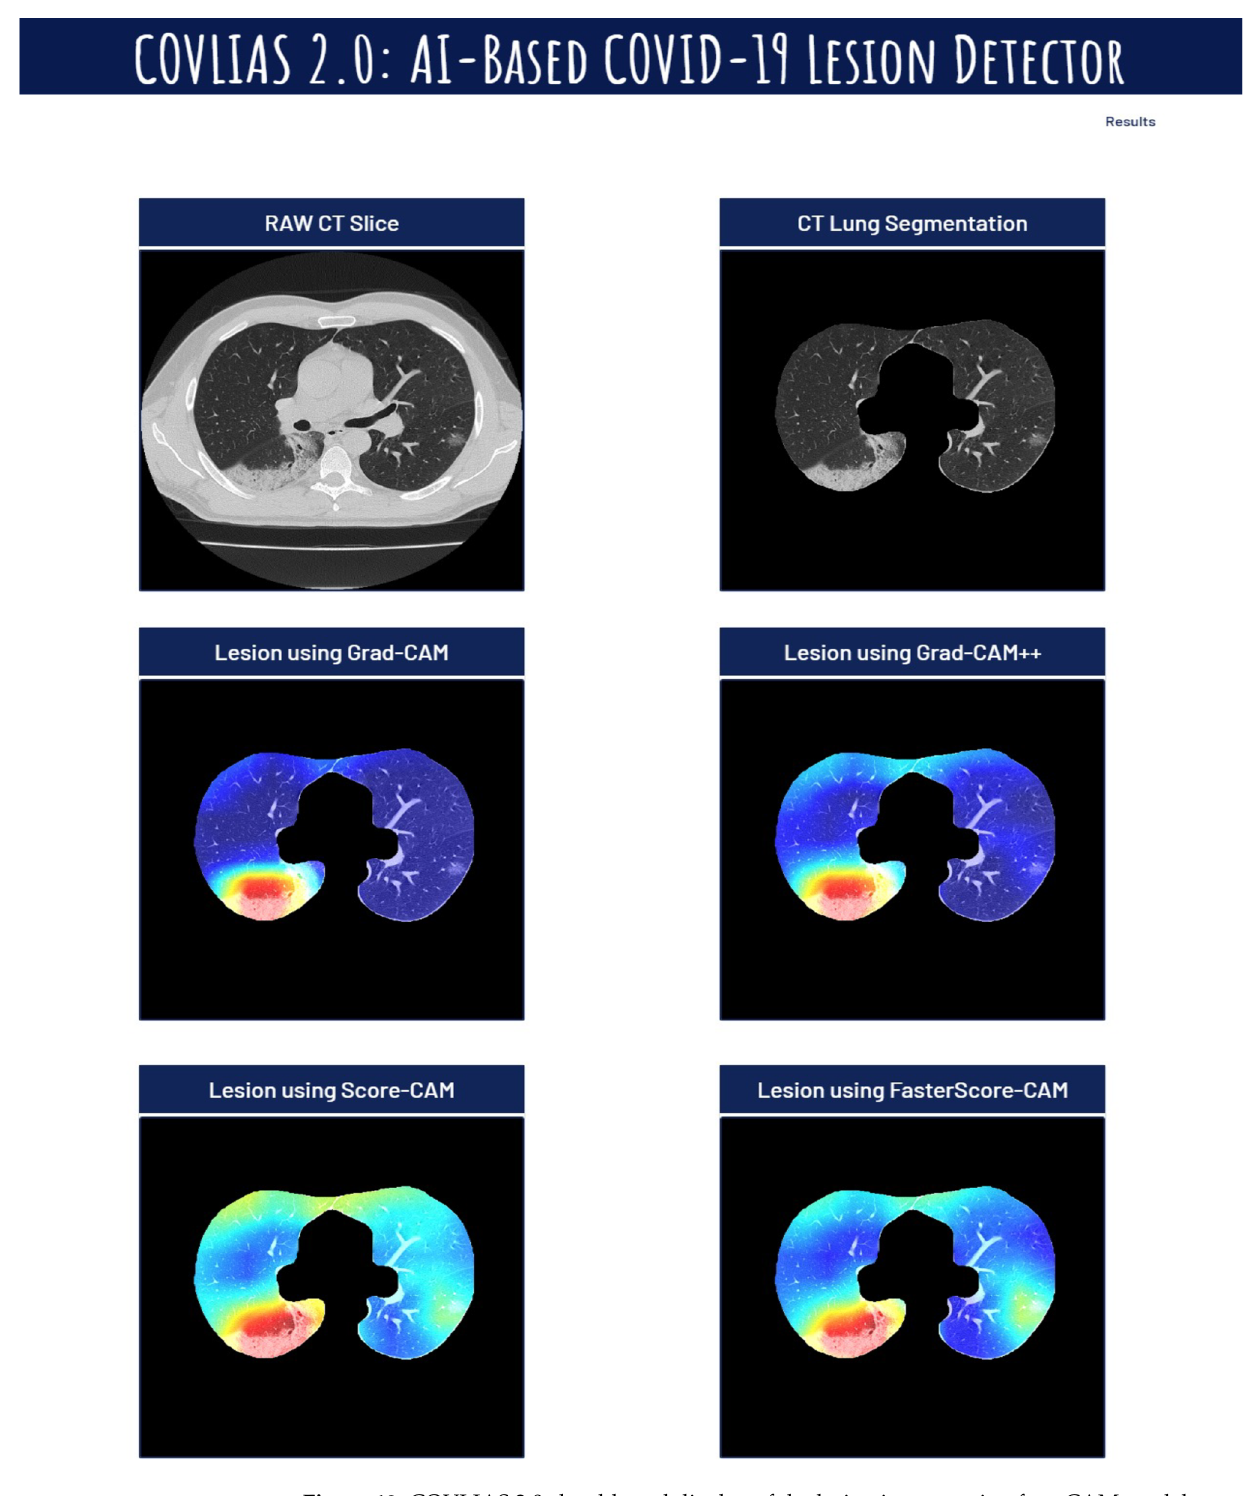
Figure 19. COVLIAS 2.0 cloud-based display of the lesion images using four CAM models.